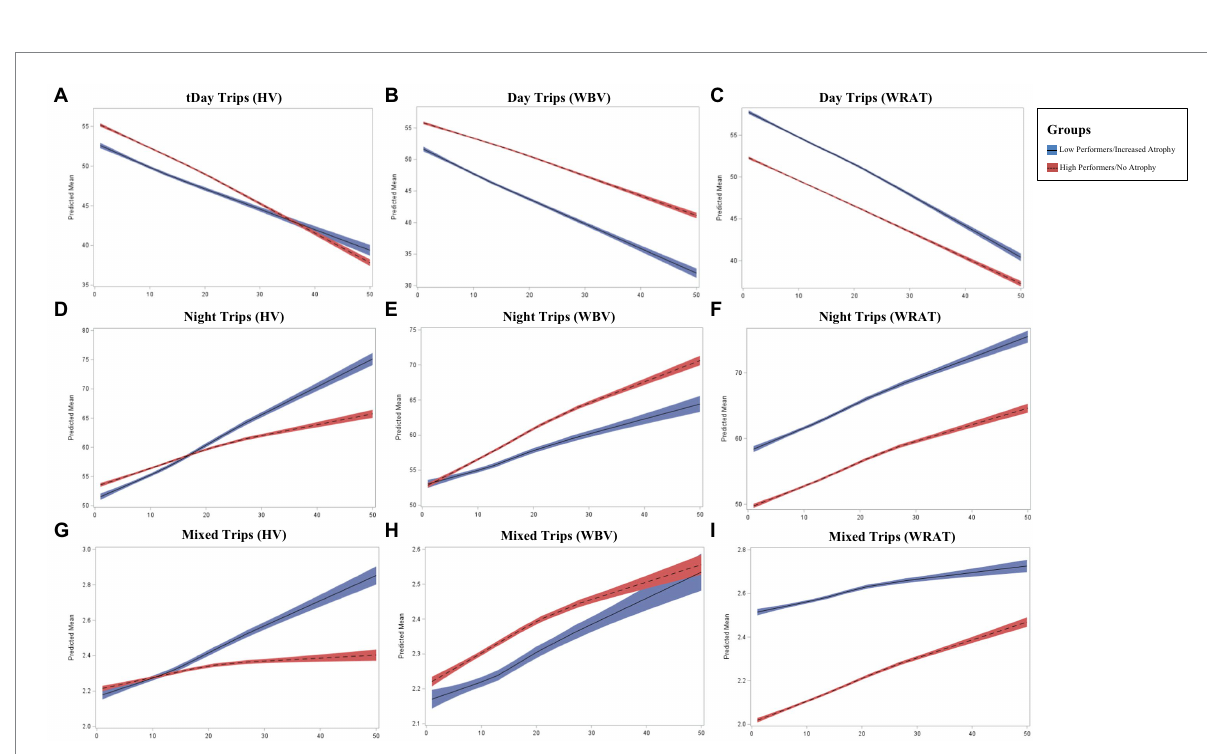
FIGURE 2 Longitudinal changed in driving frequency outcomes across groups where x -axis represents the number of months (0–50) and y -axis represents the predicted mean in driving outcome (A–I)